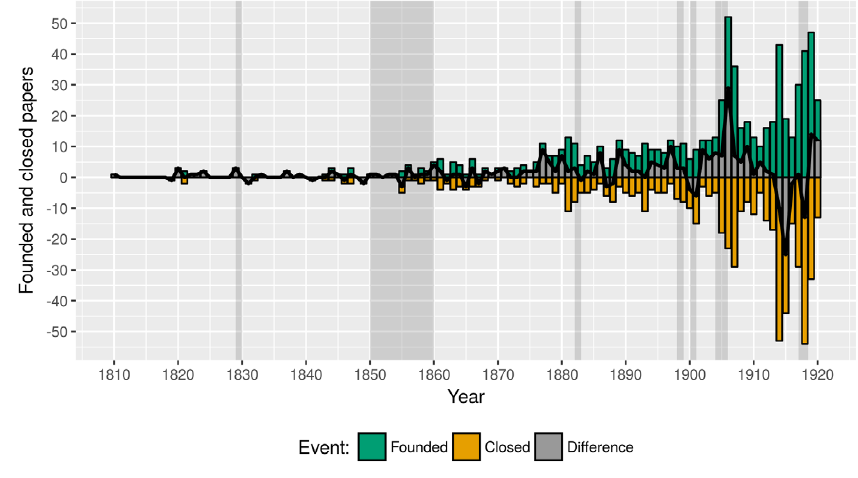
Fig. 3 The founding of new newspapers and the closing of existing ones, 1810–1920. The following key junctures are plotted in the figure: the introduction of censorship of all printed documents prior to publication (1829); a partial ban on publishing articles in the Finnish language on subjects other than the economy and religion (1850–55); the relaxing of censorship (1855, 1860); increased powers for the Governor-General to control newspapers (1882); Bobrikov appointed Governor-General (1898); the Governor-General is allowed to ban advertisements (1900); a ban on single-issue sales and the murder of Bobrikov (1904); press freedom introduced (November 1905); Finland’s declaration of independence and the civil war